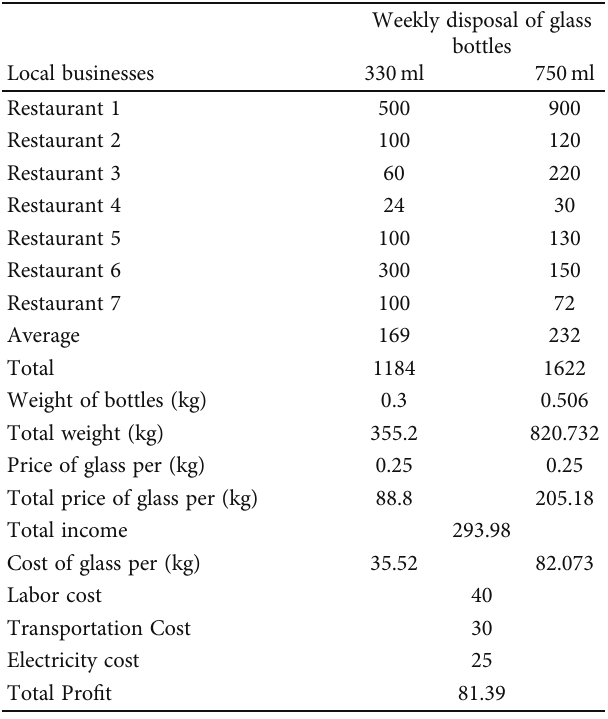
Table 11: Survey on weekly glass bottles disposal. Weekly disposal of